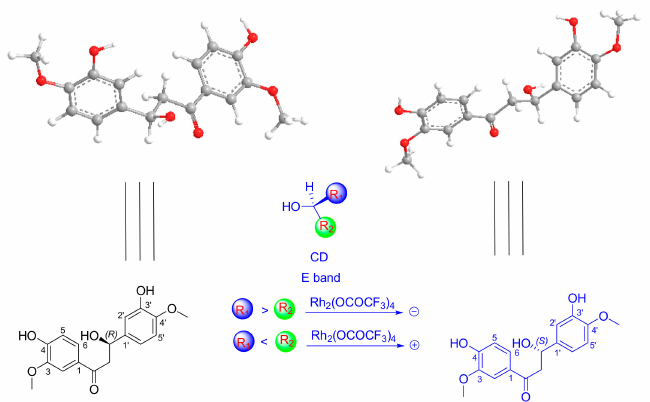
Figure 5. The conformations of (+)- 1 and ( − )- 1 , and the application of the bulkiness rule for tertiary alcohols.